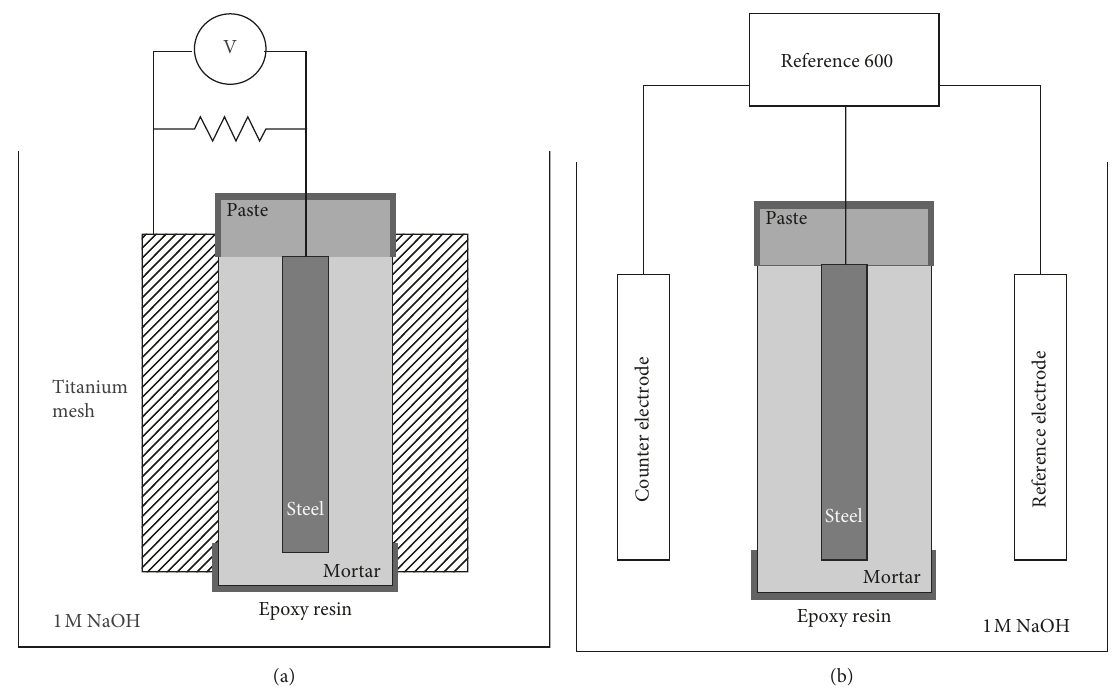
Figure 1: Schematic of the experimental setup of (a) galvanic cell monitoring and (b) LPR measurement.